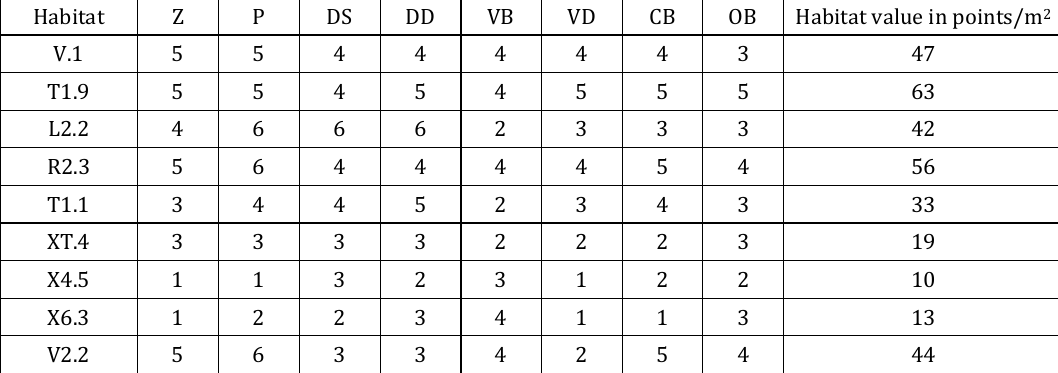
Table 2. Points for selected natural habitats (after Seják et al., 2003)